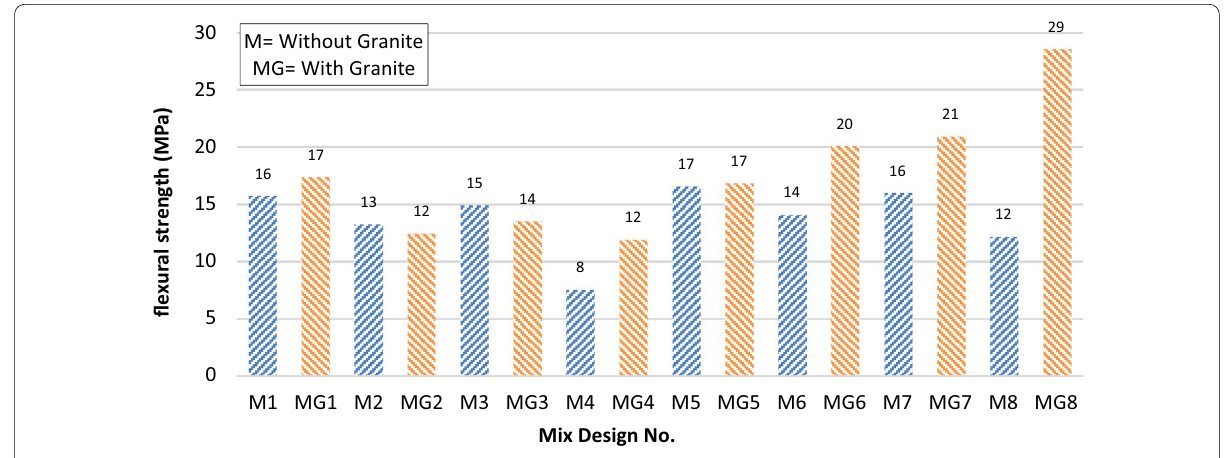
Fig. 6 Flexural strength of mixes with and without GW after heating